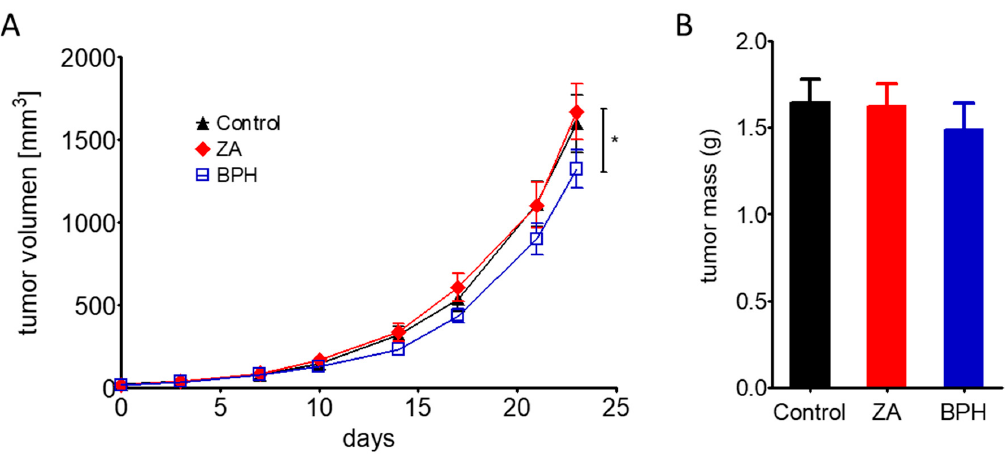
Figure 6. Antitumor effect of ZA (red) compared to BPH (blue) on the M24met cell line in SCID female mice. ( A ) Results after 23 day-long treatment with 1.47- μ mol/kg ZA or BPH showed that BPH was significantly more effective at inhibiting tumor growth than ZA. ( B ). BPH slightly decreased the tumor mass; however, it was not statistically significant. Data are shown as the average ± SEM from n = 10 groups. Asterisks mean a significant difference between BPH and ZA by * p < 0.05.